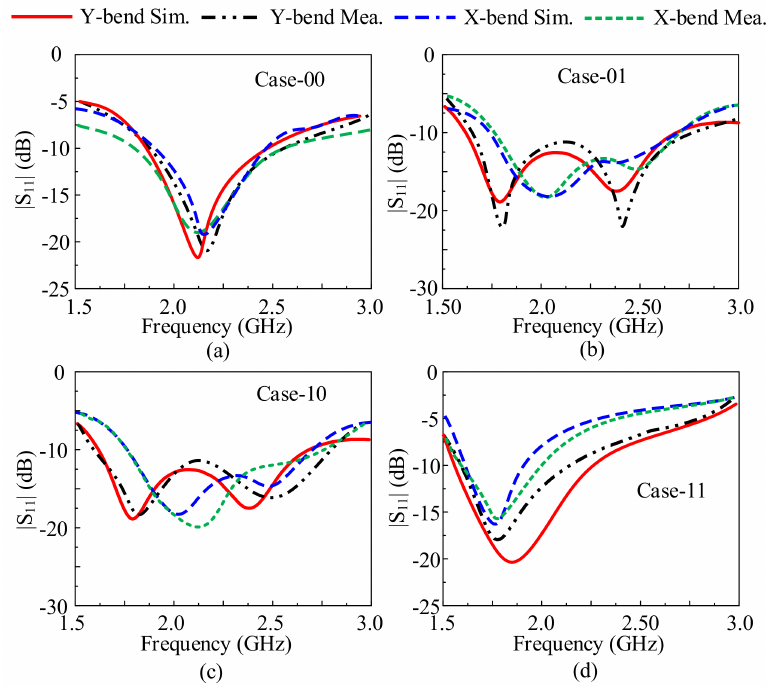
Figure 10. S-parameters for the antenna with different switching states under bending conditions ( a ) case–00; ( b ) case–01; ( c ) case–10; ( d )